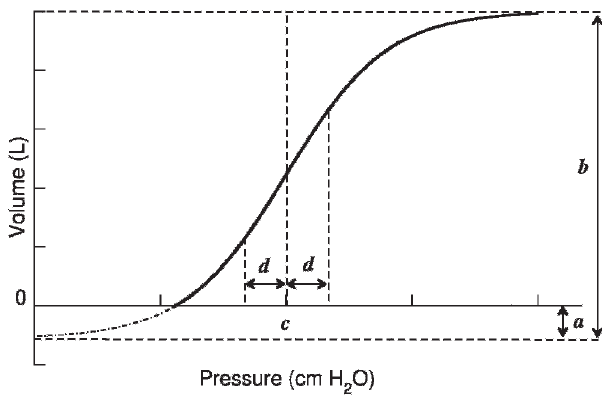
Figure 1 - ParametersforthesigmoidalequationV= a + b /(1 + e –(P- c )/ d ). V is absolute lung volume, P is airway pressure, a is the difference in volume between EELV at ZEEP and residual volume, and b is the volume from a to the upper asymptote approximating vital capacity. The parameter c is the pressure at the mathematical sigmoidal inflection point and represents the pressure at which compliance is maximal. Parameter d is proportional to the pressure range at which most of the volume change occurs and is measured in cm H 2 O.